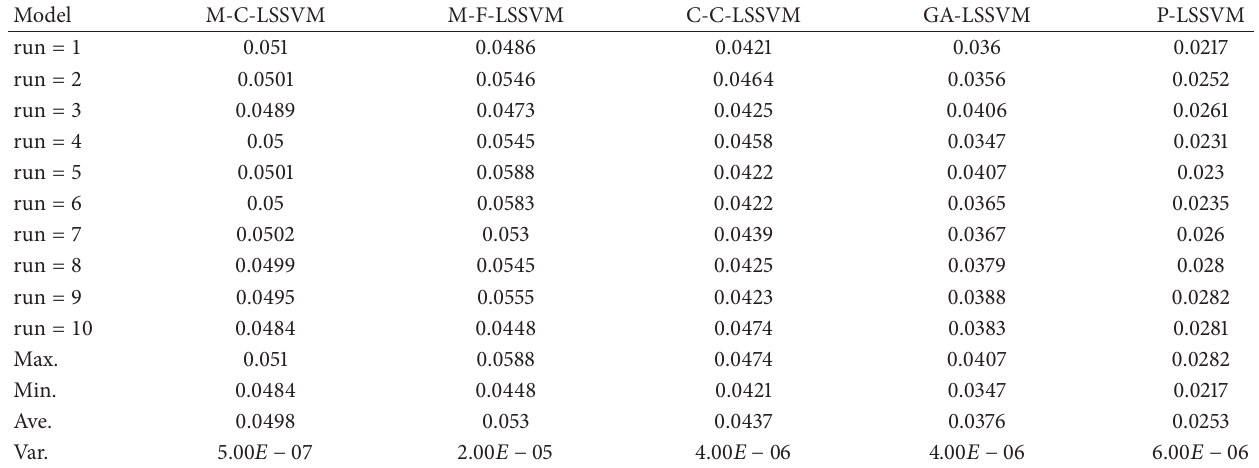
Table 3: Five models predicted error based on RMSE for FM broadcasting band.